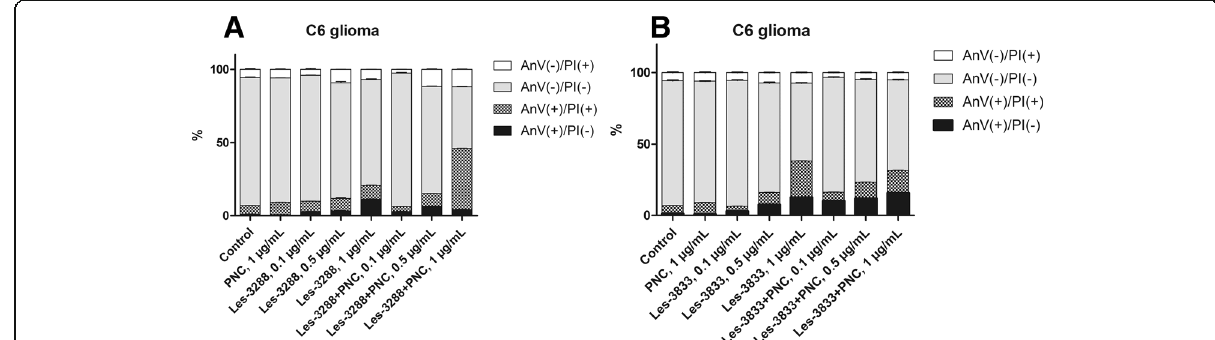
Fig. 8 Comparison of the pro-apoptotic activity of Les-3288 ( a ) and Les-3833 ( b ) compounds and their complexes with the polymeric nanocarrier